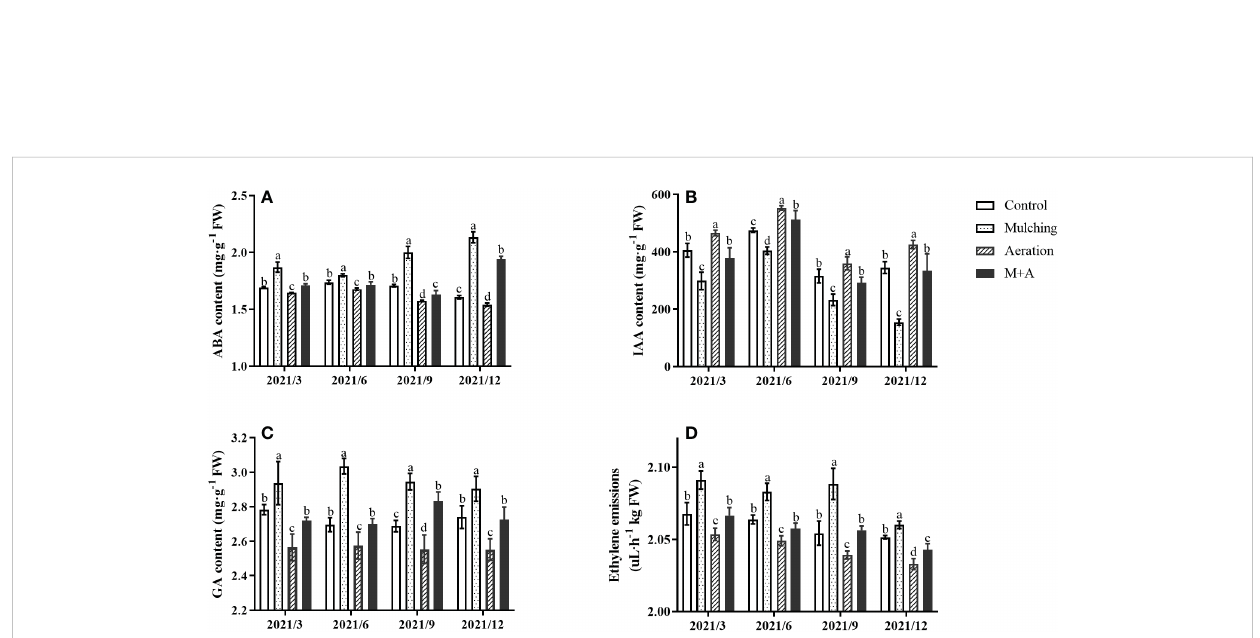
FIGURE 4 Effects of aeration on the contents of the phytohormones ABA (A) , IAA (B) , GA (C) , and ETH (D) in the bamboo forest under mulching conditions (Control, Mulching, Aeration, M + A). The vertical bars ± re fl ect the standard deviation of the mean. Different letters in the same period represent different signi fi cance ( p< 0.05). ETH, ethylene; ABA, abscisic acid; GA, gibberellic acid; IAA, indole-3-acetic